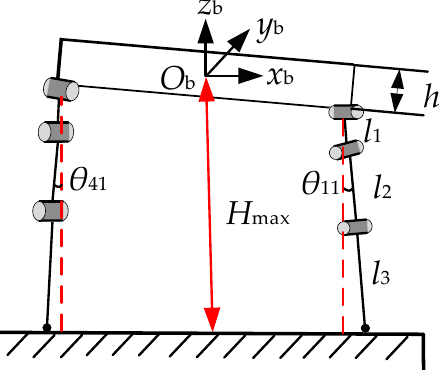
Figure 3. Height model of the robot supported by two feet.